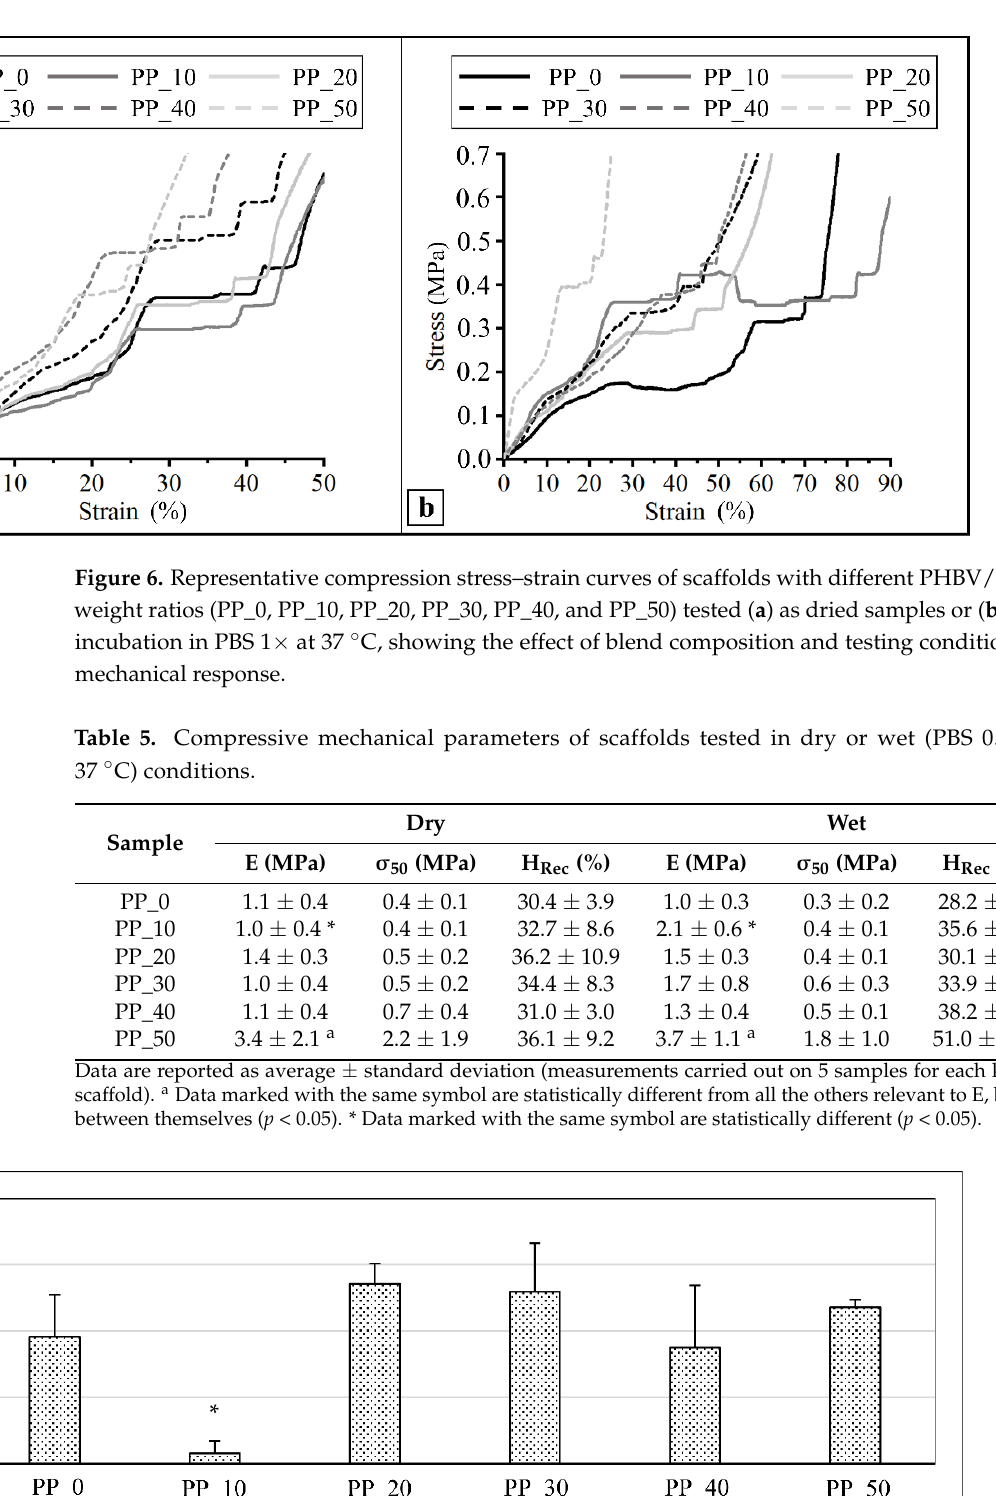
Figure 7. MC3T3-E1 cell viability on scaffolds with different PHBV/PLGA weight ratios (PP_0,